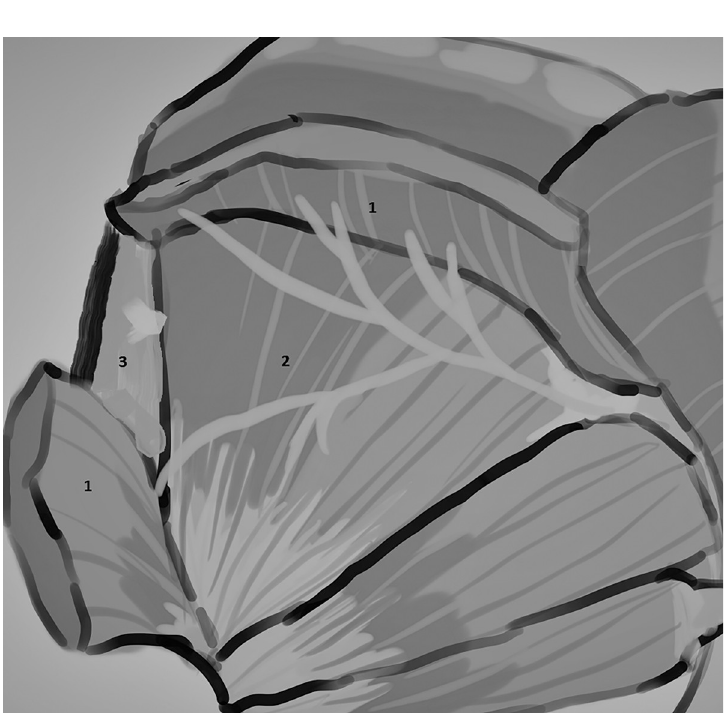
Fig 13. Superior gluteal nerve, tree type–anatomical diagram of the nerve path (thanks to Julia Derkowska), 1–gluteus medius muscle, 2–gluteus minimus muscle, 3–tensor fasciae latae muscle.